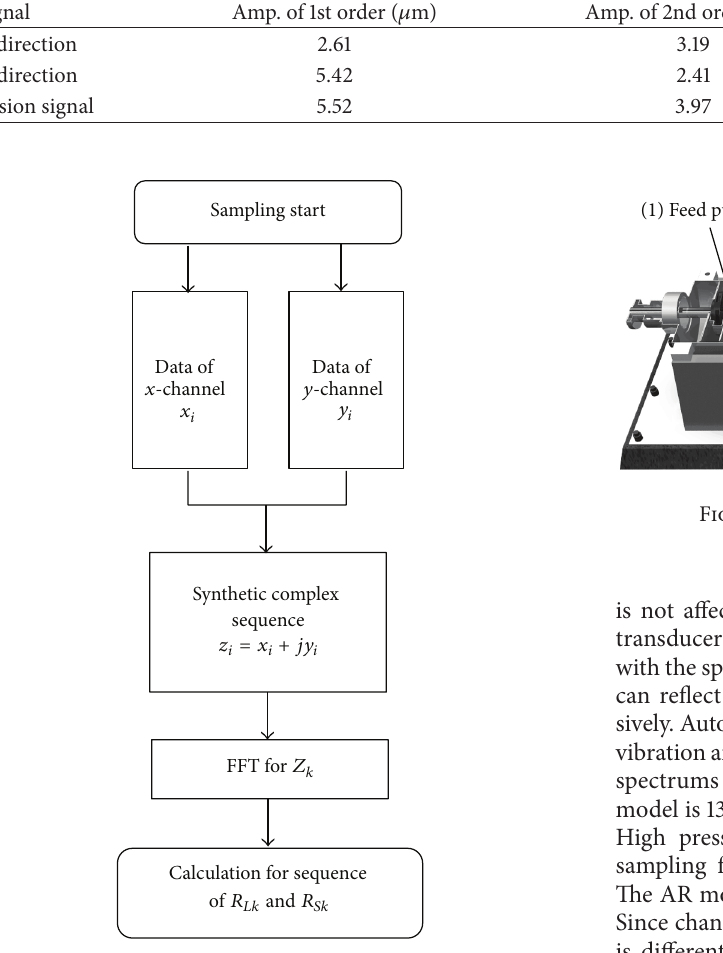
Figure 7: Full-vector fusion calculation.